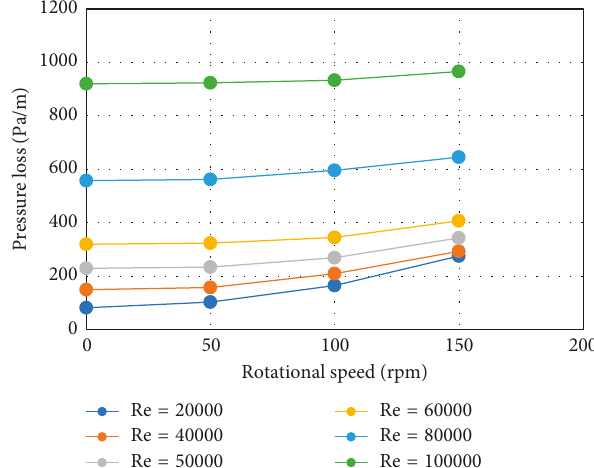
Figure 15: Effect of inner pipe rotation on pressure loss.